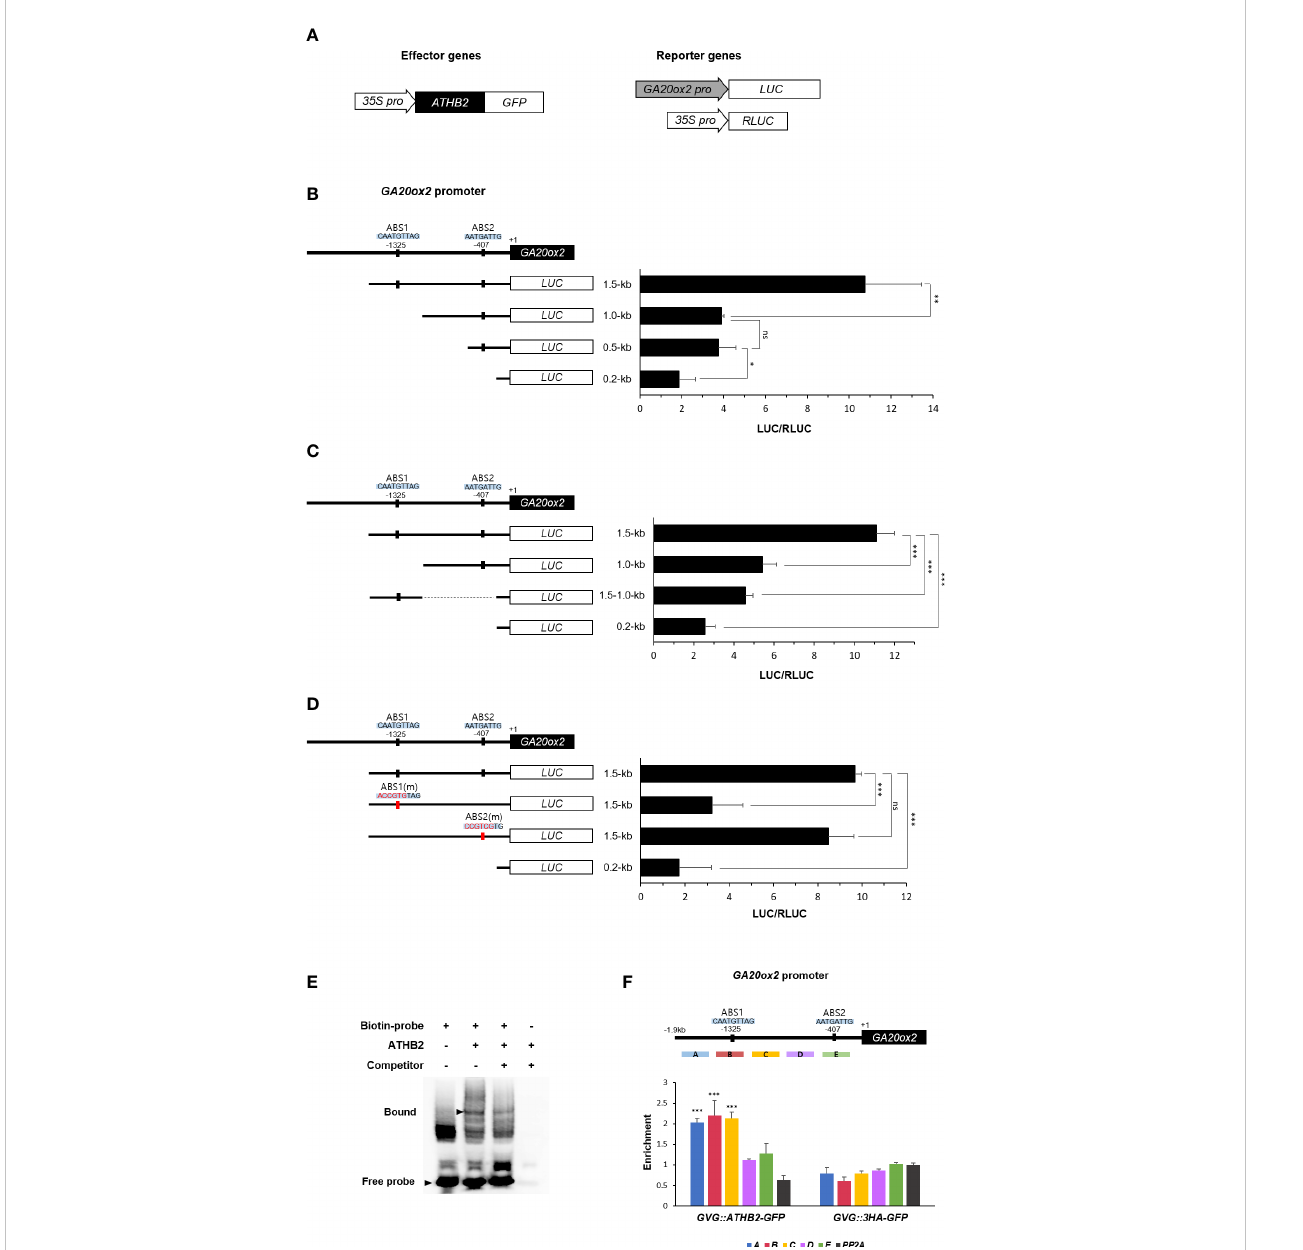
FIGURE 3 Activation of GA20ox2 by ATHB2 binding to an upstream region of GA20ox2 . (A) Luciferase assays using different lengths of GA20ox2 upstream region fused with fi re fl y luciferase ( GA20ox2 pro::LUC ) as reporters and 35S pro::ATHB2-GFP as an effector construct were performed. (B) Different lengths of GA20ox2 upstream region (1.5-kb, 1.0-kb, 0.5-kb, and 0.2-kb upstream regions) fused with fi re fl y luciferase were used as reporter constructs, and 35S pro::RLUC was used as internal control. Fire fl y luciferase (LUC) activity was normalized with Renilla luciferase (RLUC) activity. The diagram shows two putative ATHB2 binding sites (ABS1 and ABS2) in GA20ox2 upstream region. (C) A region of the GA20ox2 promoter occupying between -1.0-kb ~ -1.5-kb upstream was fused to a LUC reporter with the minimal promoter region of GA20ox2 (-0.2 kb fragment) tested for the activation activity. (D) ABS1 and ABS2 on GA20ox2 promoter were mutated, respectively; ABS1(m) and ABS2(m). The resulting constructs were used for luciferase assay. (E) An electrophoretic mobility shift assay (EMSA) was performed using a 31-mer of biotin-labeled oligonucleotides fl anking the ABS1 sequence. Puri fi ed 6X His-tagged ATHB2 protein was incubated with labelled oligonucleotides (second lane). The same EMSA experiment with 100X molar excess of unlabeled oligonucleotides as competitor was examined as well for indicating the speci fi city of ATHB2 binding to ABS1. Arrowheads indicate free and bound oligonucleotides separated in a native gel. (F) ChIP assay showing enrichments of GA20ox2 promoter fragments by ATHB2. Schematic diagram indicates ATHB binding sites (ABS1 and ABS2) and ChIP amplicons (A-E) in the upstream region of GA20ox2 . The enrichment of each DNA fragment was normalized by the level of input DNA and the ChIP enrichment value of the control PP2A promoter. Asterisks indicate signi fi cant differences from the enrichment of PP2A genomic fragments Results are representative of three independent experiments. Data shown are mean ± SD (n=3). All data were statistically evaluated using one-way ANOVA: *P < 0.05; **P < 0.01; ***P < 0.005; ns, no signi fi cant